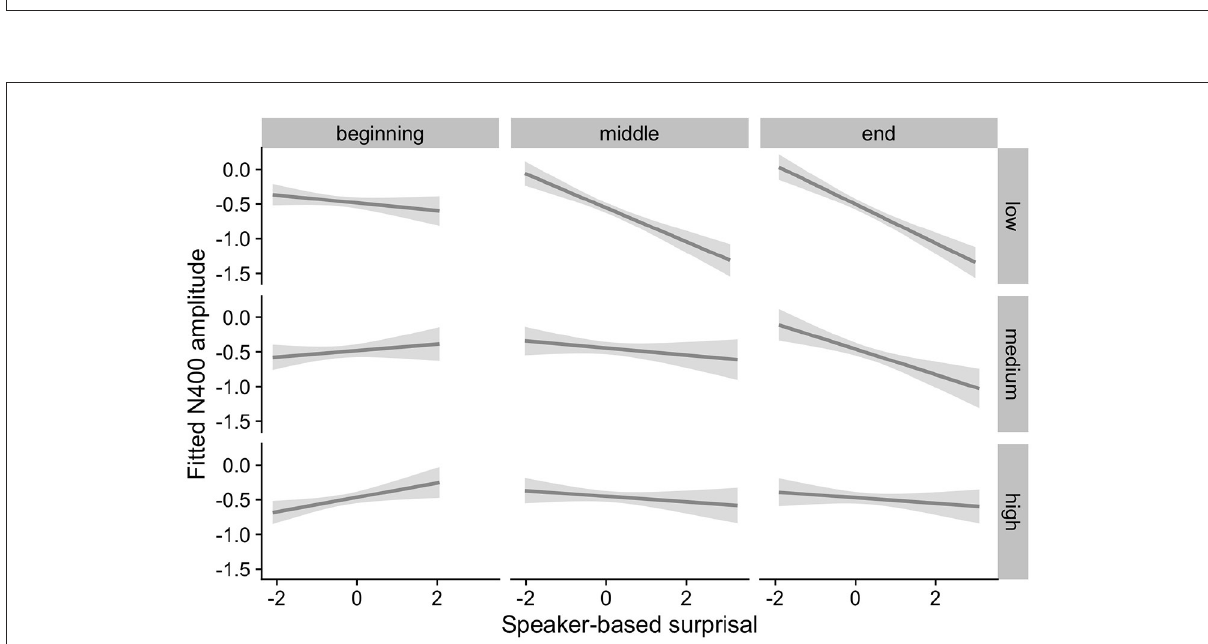
FIGURE5 Effect of individual alpha frequency (IAF) on changes in the relationship between speaker-based surprisal (z-transformed) and N400 amplitude over the course of Experiment 1. The figure visualizes partial effects as calculated using the remef package, adjusted for canonicity and frequency. Note that position in the experiment (operationalised via epoch in the statistical model) is trichotomised into beginning, middle and end for visualization purposes only; epoch was included in the model as a continuous predictor. The same holds for IAF, which is trichotomised into low, medium and high for visualization purposes but was entered into the statistical model as a continuous predictor. Shaded areas indicate 95% confidence